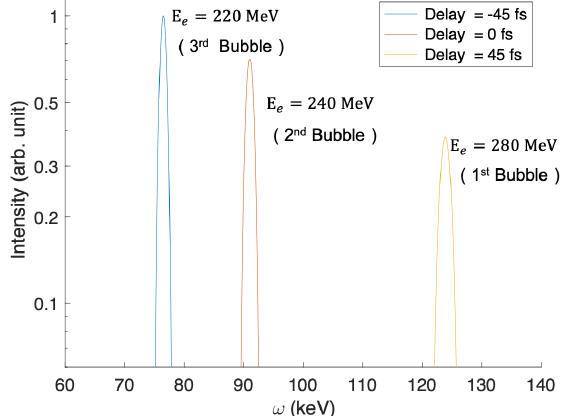
FIG. 4. TWTS x-ray spectrogram for investigating the temporal structure of the electron beam bunches. Here three electrons, representing three electron beams in respective wakefield bub- bles, are diagnosed with the delay-scanning TWTS. Three time- resolved spectral lines corresponds to respective energies of electrons in different